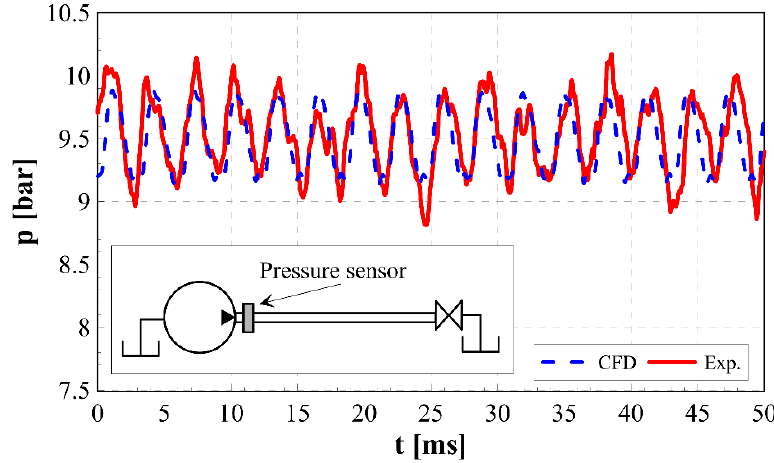
Figure 6. Pressure validation close to the delivery port (1200 rpm, 9.5 bar).